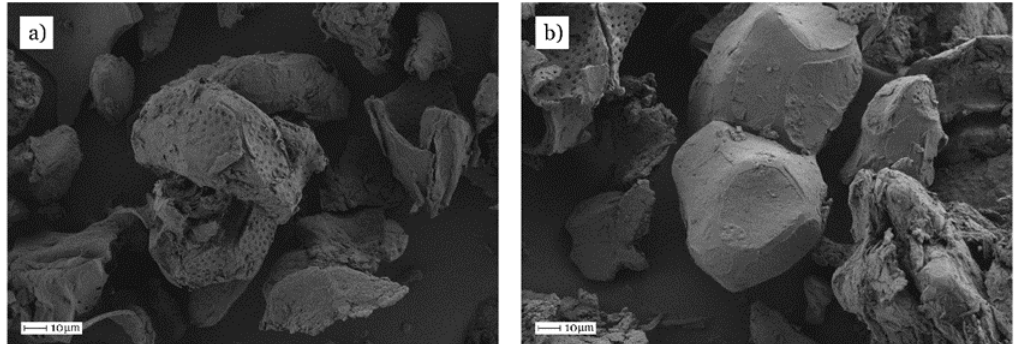
Figure 3. Field emission scanning electron microscopy (FESEM) images (500×) corresponding to almond shell flour (ASF) particles, ( a ) with spotted surfaces and porous structure and ( b ) with a smooth surface.